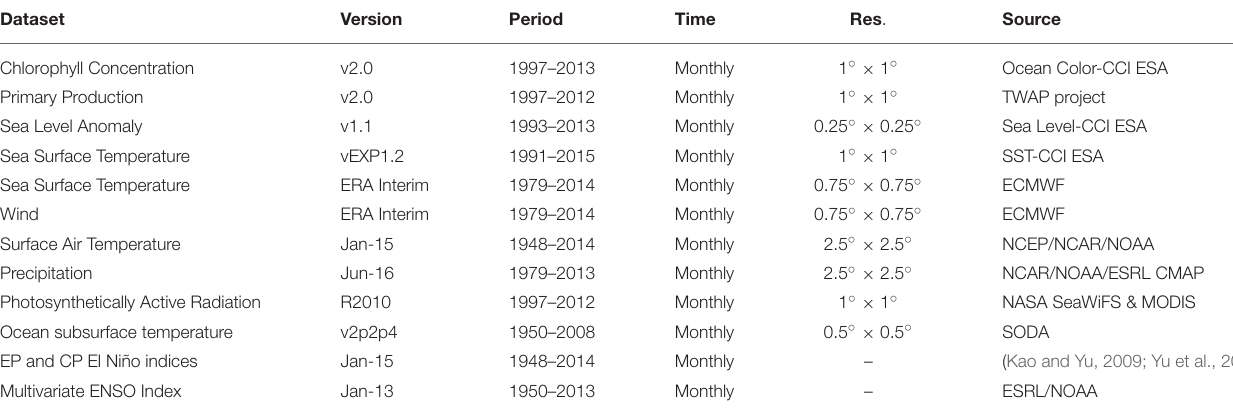
TABLE 1 | Datasets obtained for the analysis.